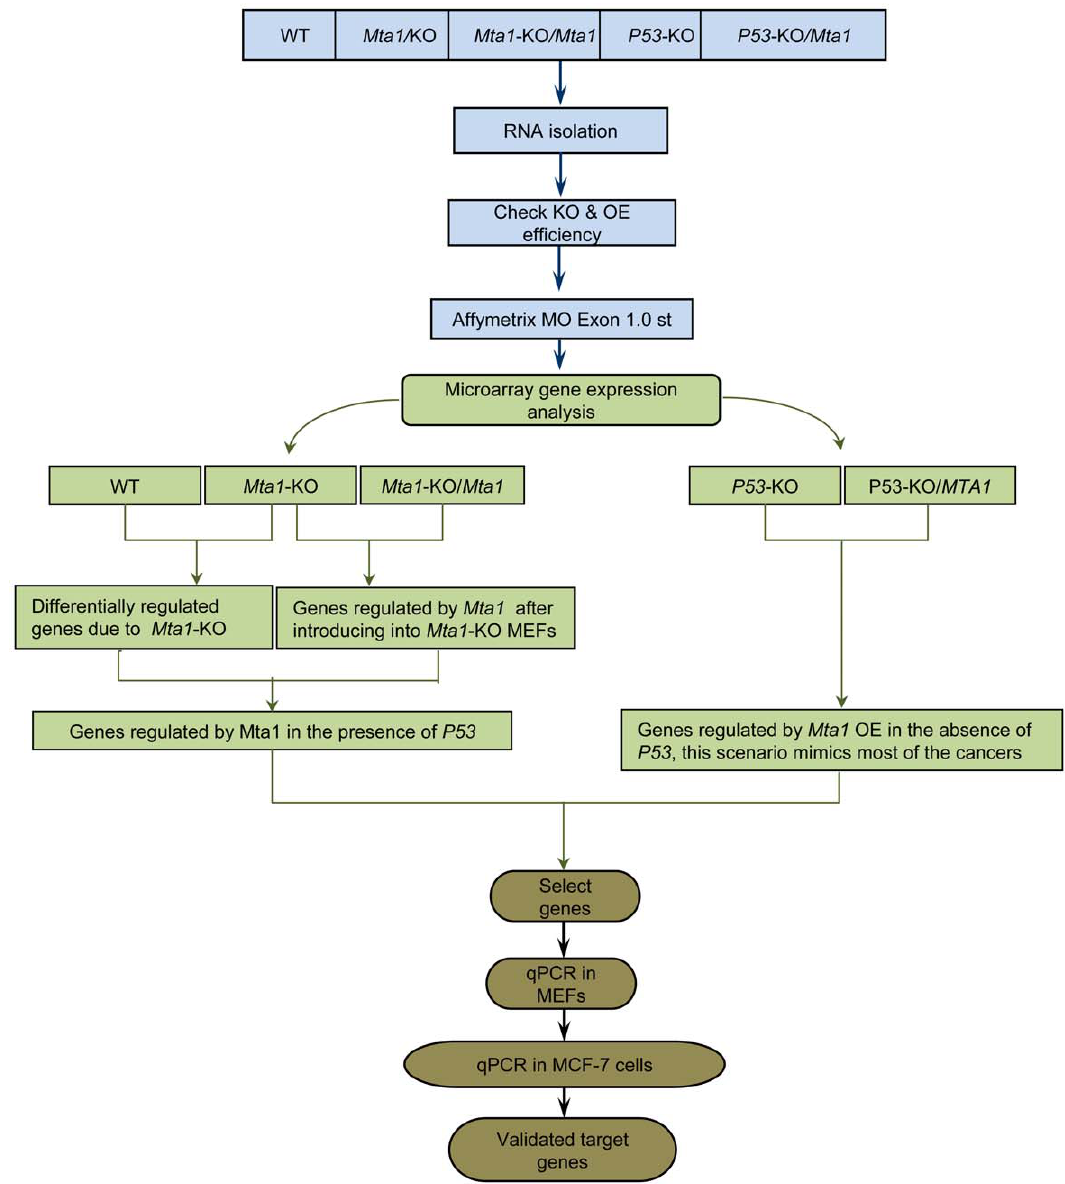
Figure 1. Schematic showing the experimental design of the study to identify the Mta1 regulated genes with/without the effect of P53 . RNA was extracted from all the samples Wild Type (WT), Mta1 knock out ( Mta1- KO), Mta1 Re-expression in the Mta1 knock out MEFS ( Mta1 -KO/ Mta1 ), P53 knock out ( P53 -KO), Mta1 over expression (OE) in the P53 knock out MEFs ( P53 -KO/ Mta1 ). cDNA was prepared, processed and hybridized onto the Affymetrix Mouse Exon 1.0 ST arrays followed by the data analysis. Samples were compared to identify the differentially regulated genes and in turn the genes regulated by Mta1 in p53 dependent/independent manner and irrespective of P53 status. Candidate genes were selected; these genes were validated using RT-qPCR assays in MEFs followed by RT-qPCR assays in MCF-7 human breast cancer cell line with the human homologs of the candidate mouse genes.